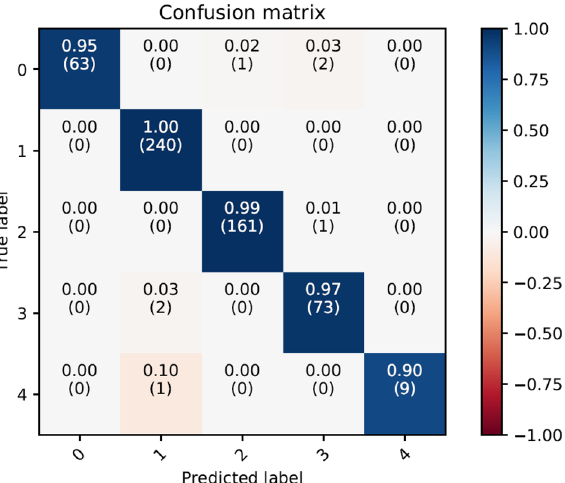
Figure 2. Confusion Matrix of the 10-fold stratified cross-validation for the CNN classifier in the original 553 SARS-CoV-2